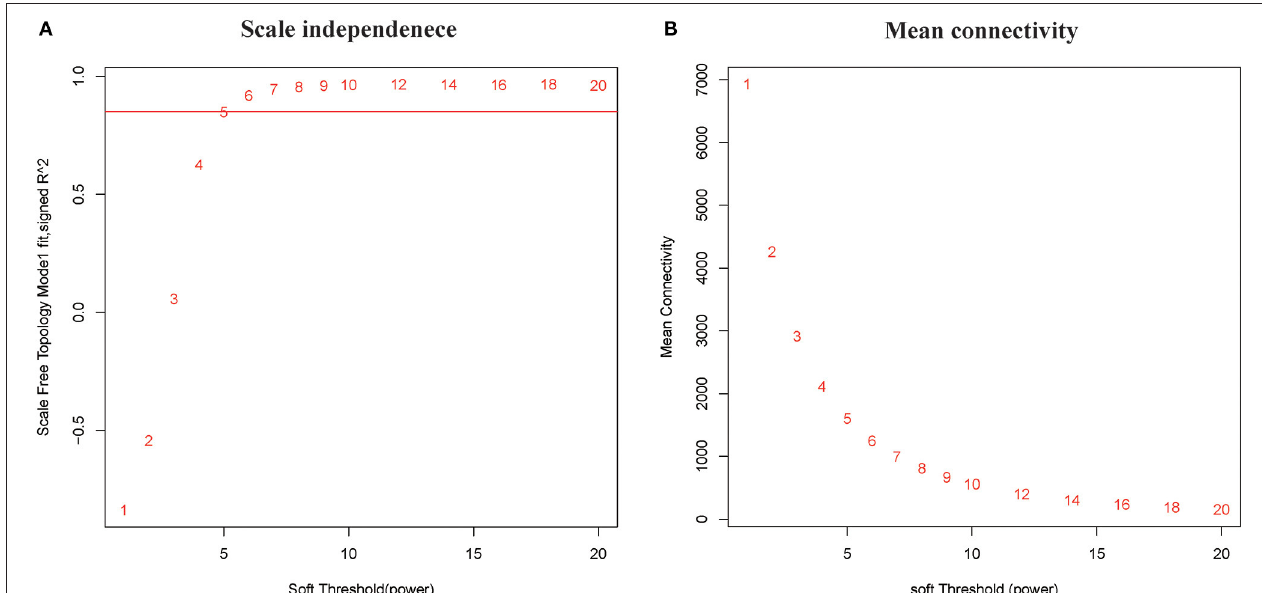
FIGURE 1 | Clustering of samples and determination of soft-thresholding power. (A) Analysis of the scale-free fit index for various soft-thresholding powers ( β ). The red line represents the merging threshold. (B) Analysis of the mean connectivity for various soft-thresholding powers. In all, 7 was the most fit power value.